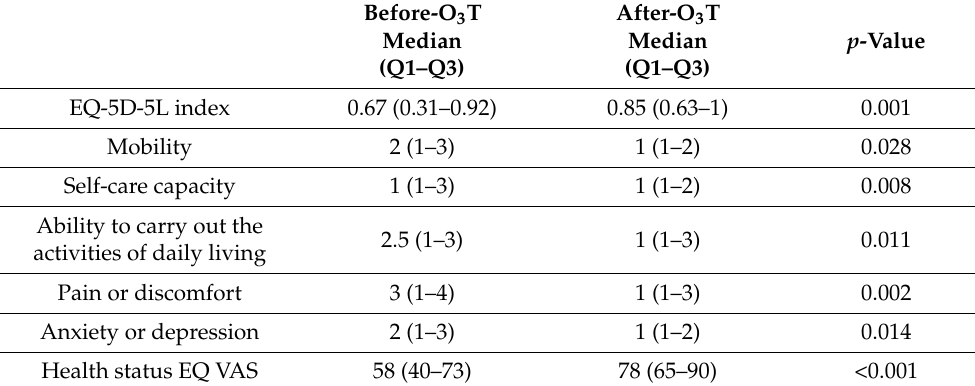
Table 1. Health-related quality of life (HRQOL) and grade of toxicity. Q1–Q3: quartiles 1 and